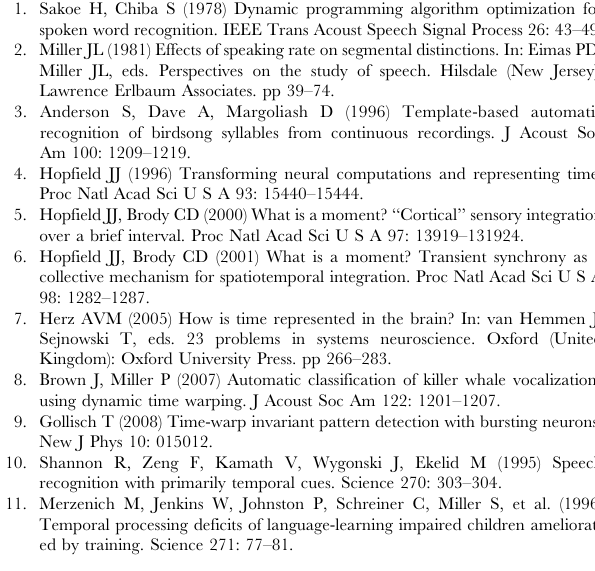
Figure S1 Effect of h-conductance on time rescaling. Time-warp distortion index computed for random latency patterns (see Materials and Methods) versus the maximal h-conductance for different values of the mean synaptic conductance G syn (cid:3) g leak : 7.2 (triangles), 10.8 (squares), and 14.4 (circles). Curves were